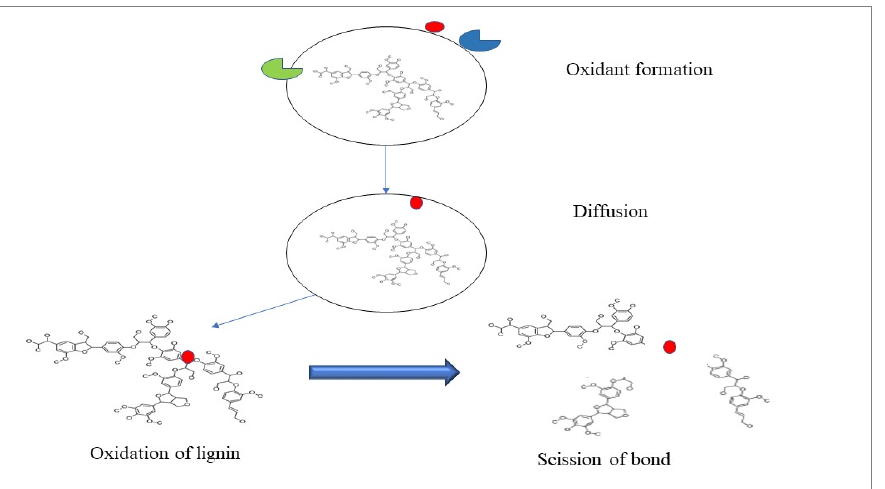
Figure 9. The mechanism involved in lignin depolymerization.